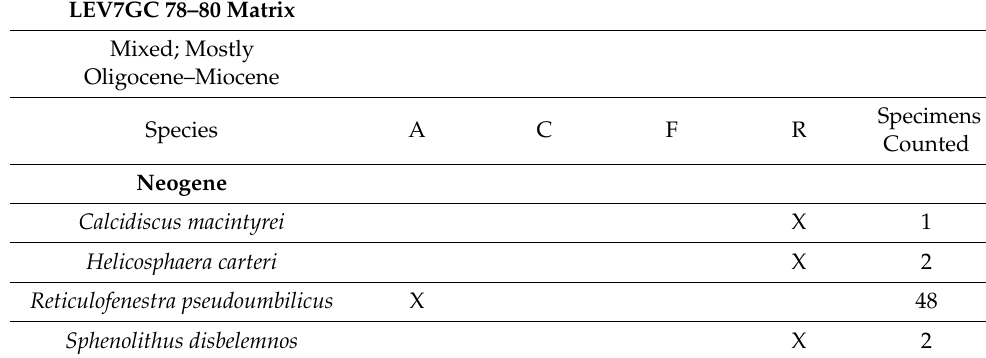
Table A33. Milano